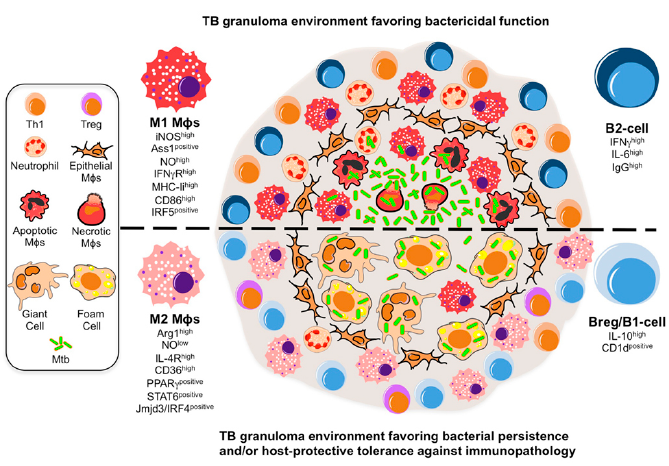
Figure 1. Model illustrating the tuberculosis (TB) granuloma environment and the roles of B cells T cells, and macrophages during TB granuloma formation. Taken from Lugo-Villarino et al.